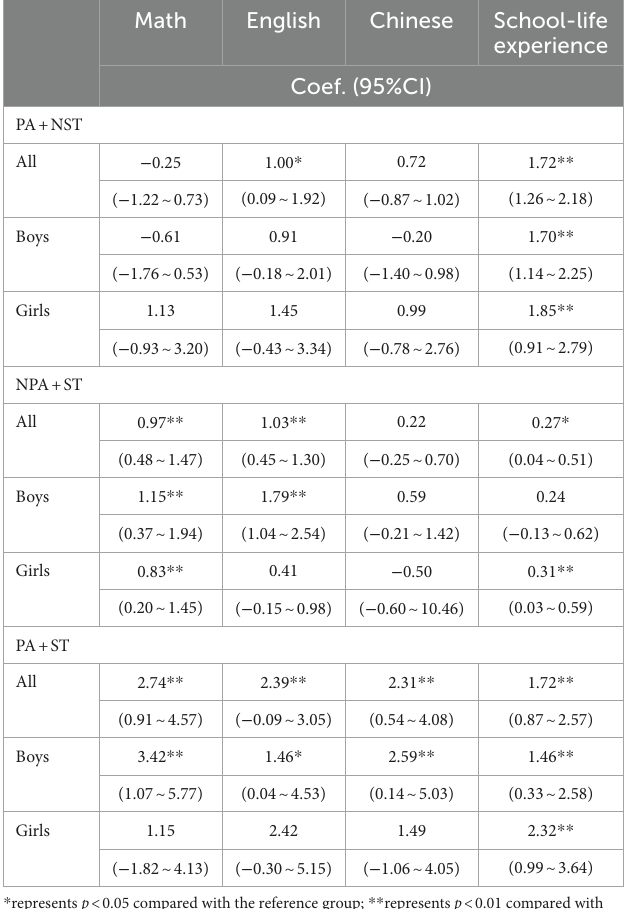
TABLE 2 The relationship between meeting physical exercise time and screen time and adolescent academic performance.